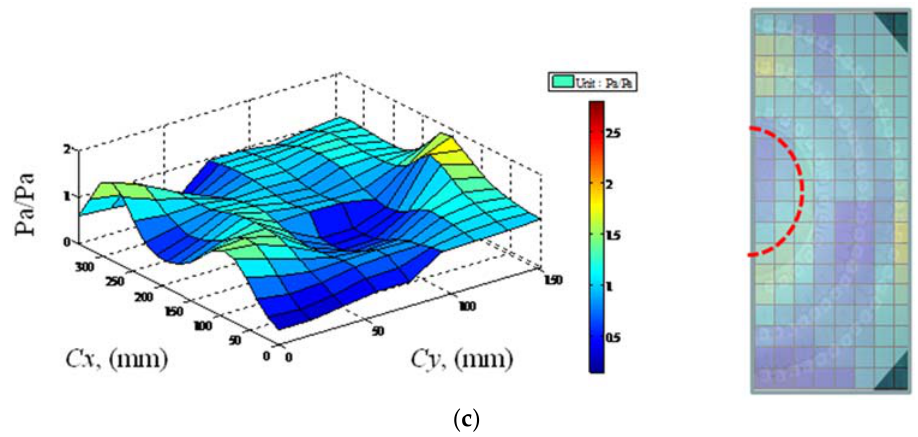
Figure 26. Normalized sound field measurements obtained within zone affected by cloak shell: ( a ) the object only; ( b ) the cloak shell only; ( c ) object and cloak shell combined. The red dotted line indicates the space occupied by object.